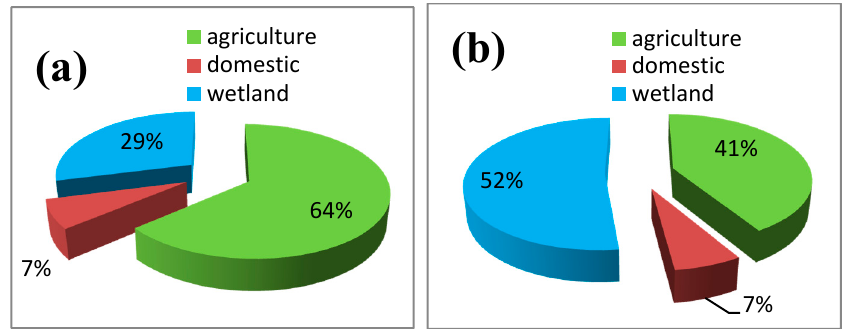
Figure 10. The fraction of long-term annual average of water allocated to different sectors ( a ) long-term profit maximization Scenario ( b ) multi-objective Scenario.